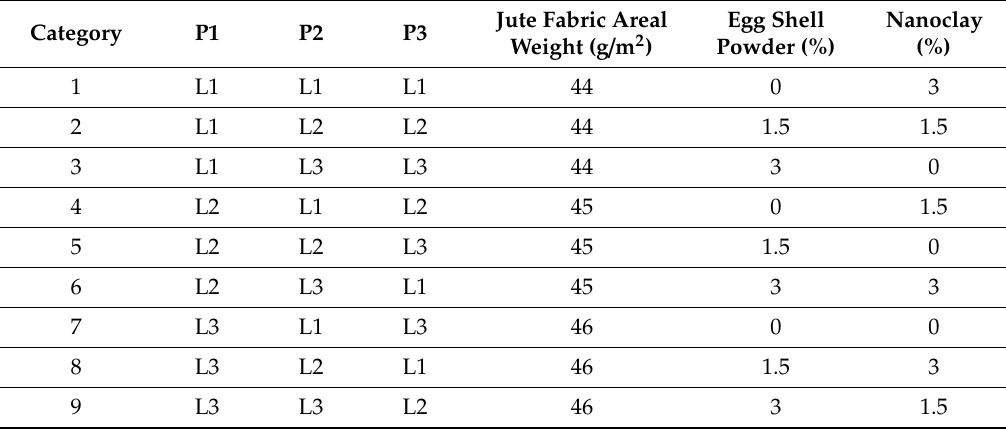
Table 11. Parameters (P) and levels (L) for the di ff erent specimen